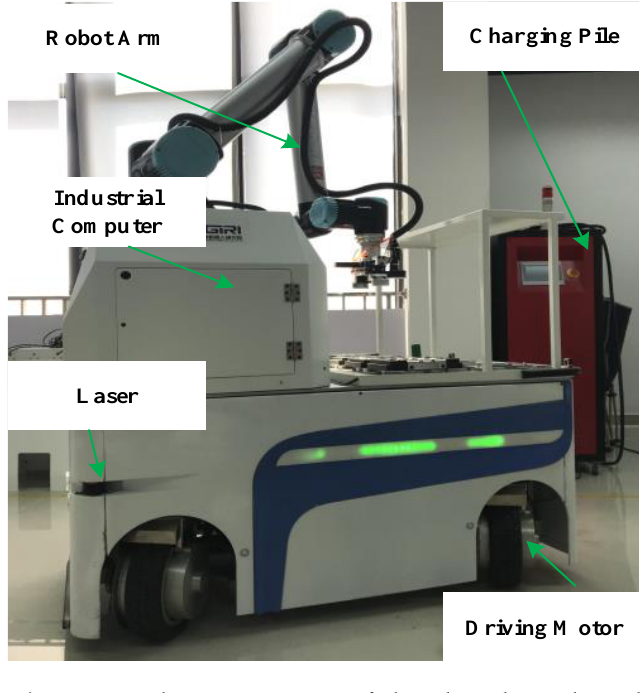
Figure 5. The prototype of the developed Forbot. Table 1. Parameters of the